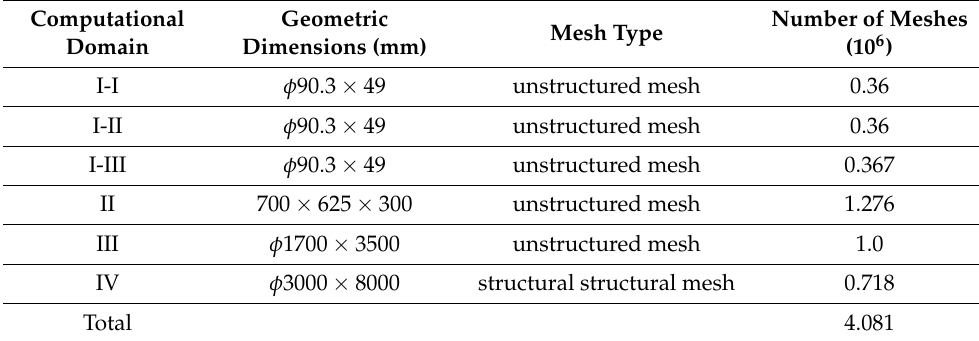
Table 9. Information about the underwater robot system’s calculation domain meshes.